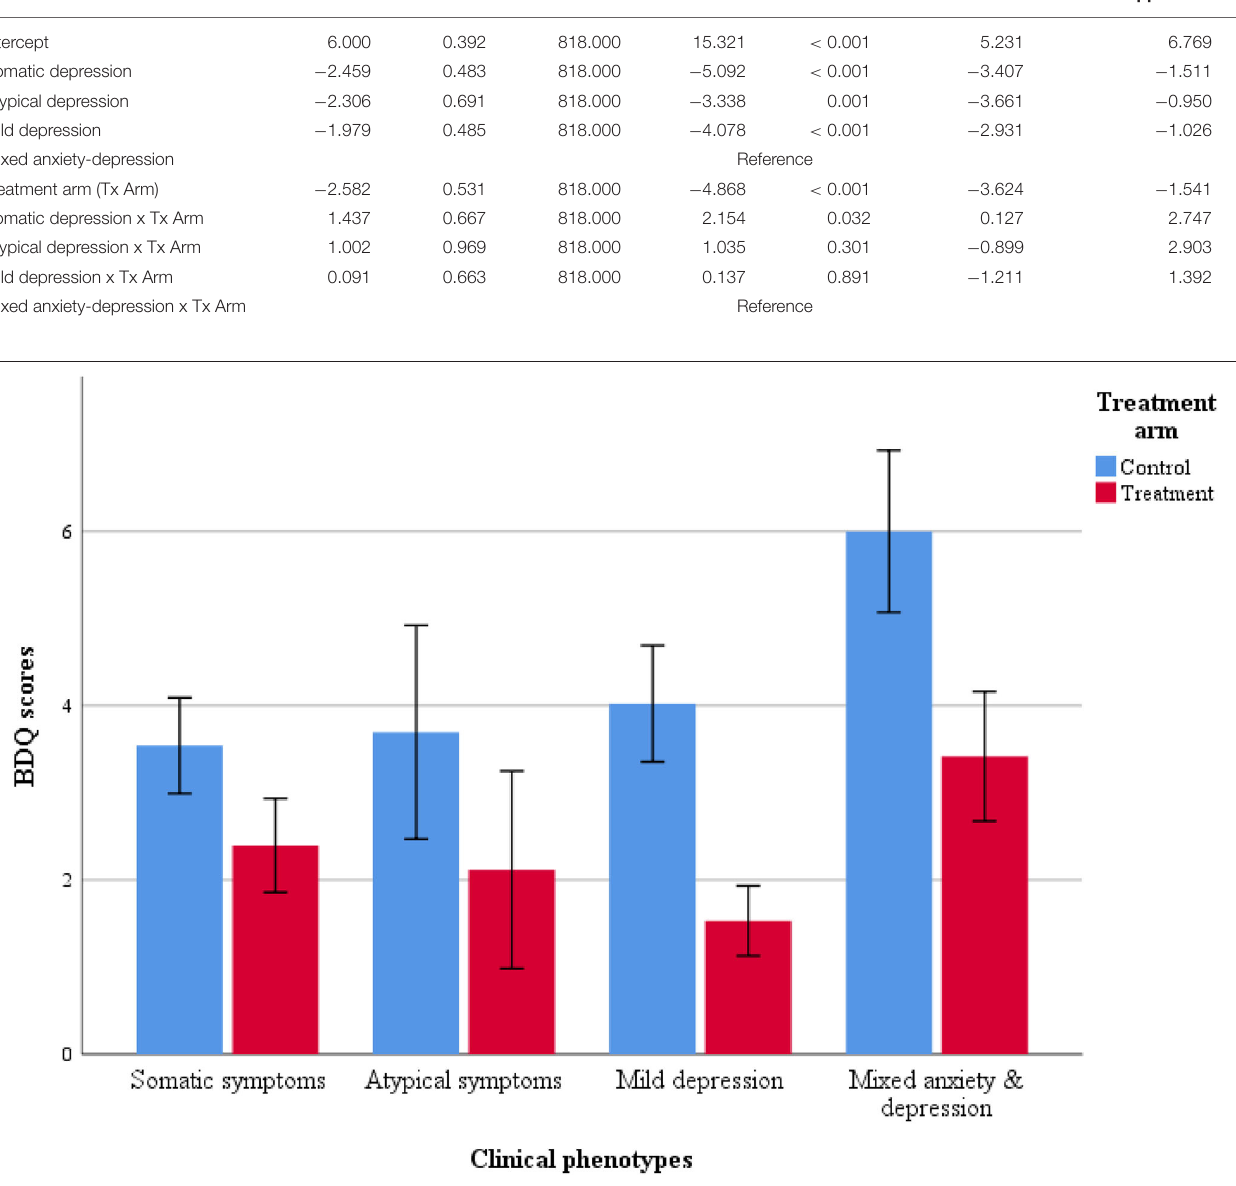
FIGURE 4 | Bar plot for disability scores in treatment